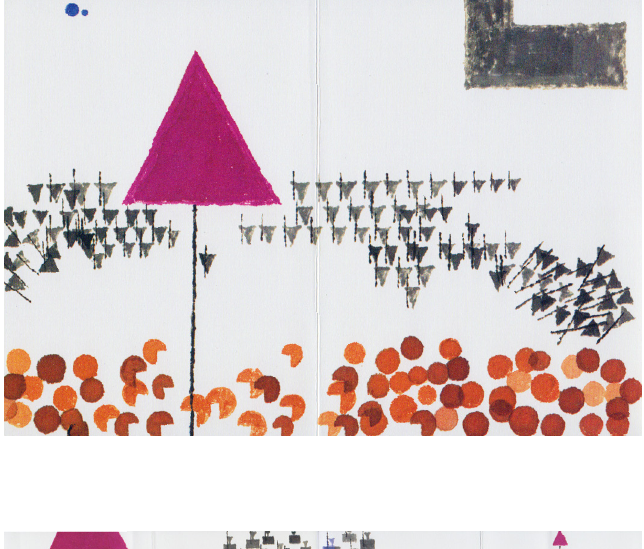
Fig. 8 Warja Lavater, The citizens of Altdorf kneel in front of Governor Gessler’s hat . Warja Lavater (1962). Wilhelm Tell . Basel: Basilius Presse.